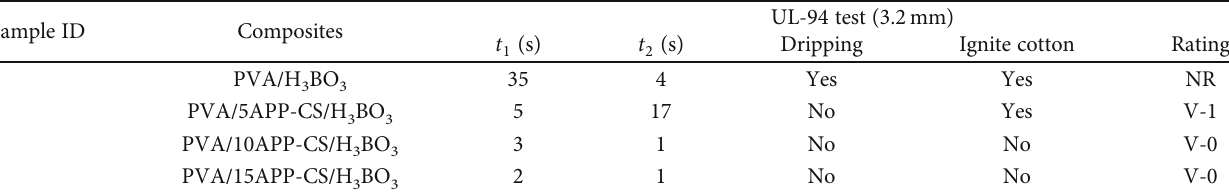
Table 3: UL-94 test results of the PVA composite aerogels.